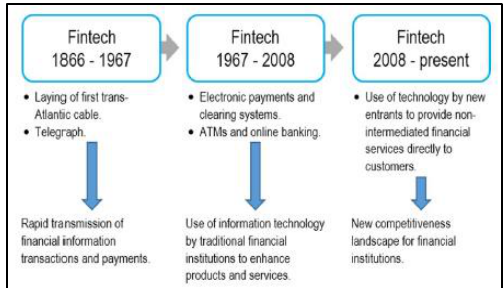
Fig. 2. Phases in Fintech